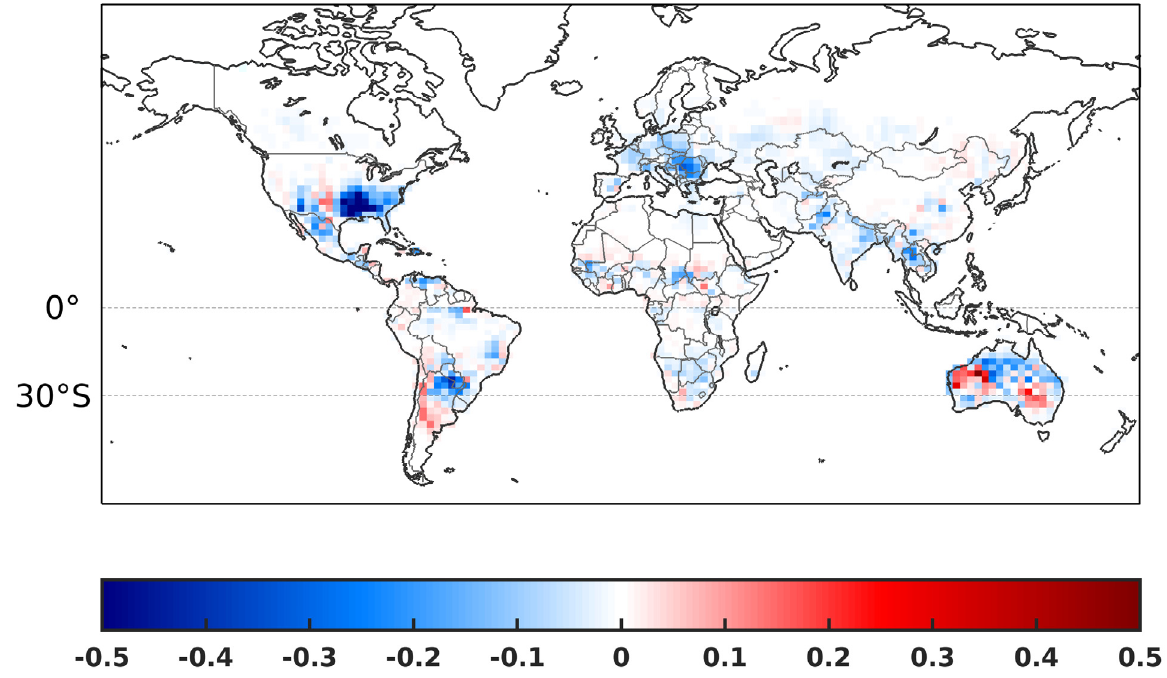
Figure 7. Difference in correlation coefficients of simulated HCHO columns with OMI HCHO columns at 2° × 2.5° spatial resolution: R 2 − R 1 , where R 1 and R 2 are the correlation coefficients from IMAGES, 𝛾 𝑆𝑀0.04 and IMAGES, 𝛾 (cid:3020)(cid:3014)(cid:3016)(cid:3017)(cid:3021) simulations (displayed in Figure S7), respectively.